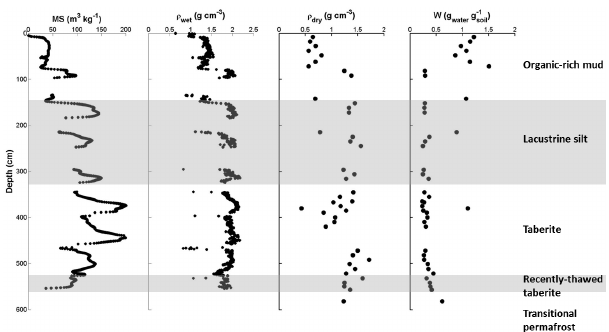
Figure 4. Depth profiles for magnetic susceptibility (MS), wet bulk density ( ρ wet ), dry bulk density ( ρ dry ), and gravimetric water con- tent (W) in the Vault Lake sediment core. Two MS values at 95.4 and 405.4cm were − 493 . 1 and − 488 . 0m 3 kg − 1 , respectively (not shown).